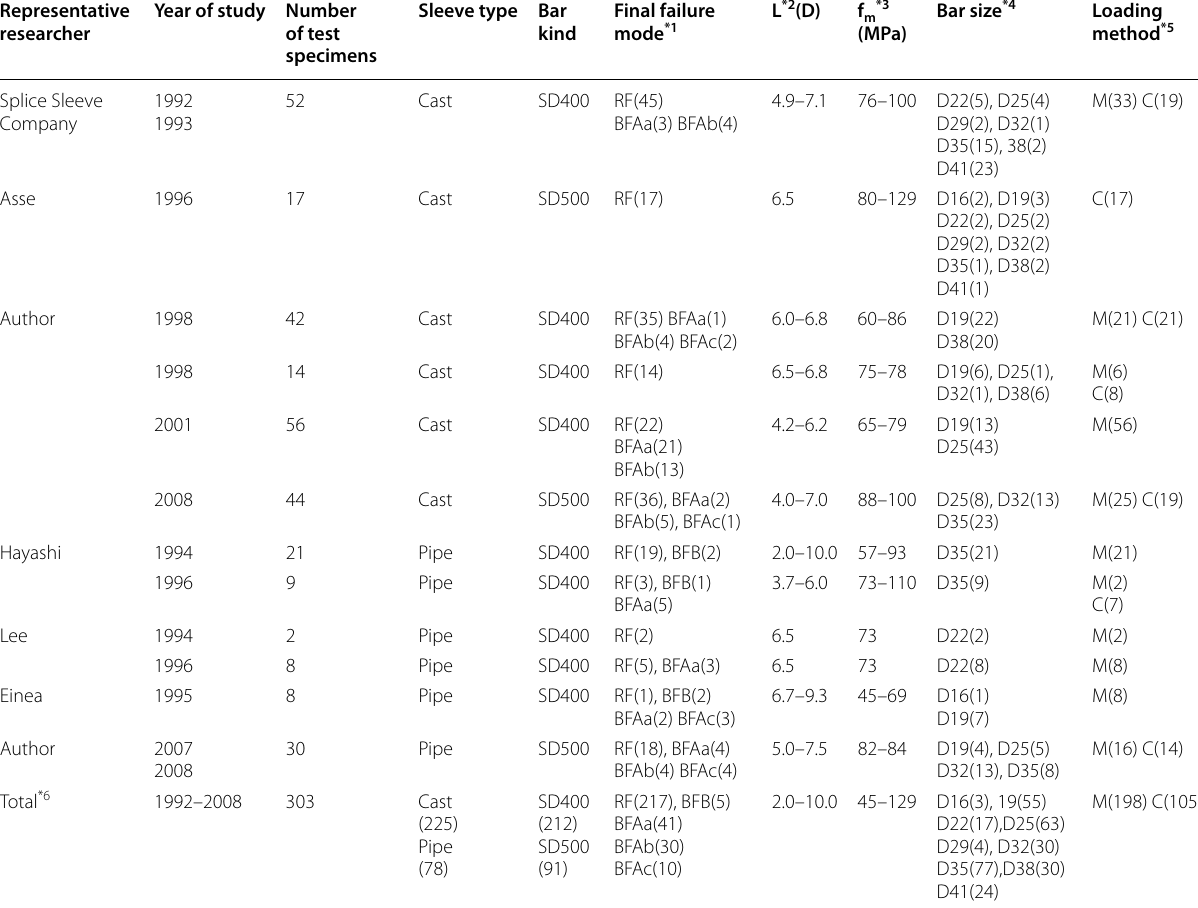
Table 1 Overview of experimental